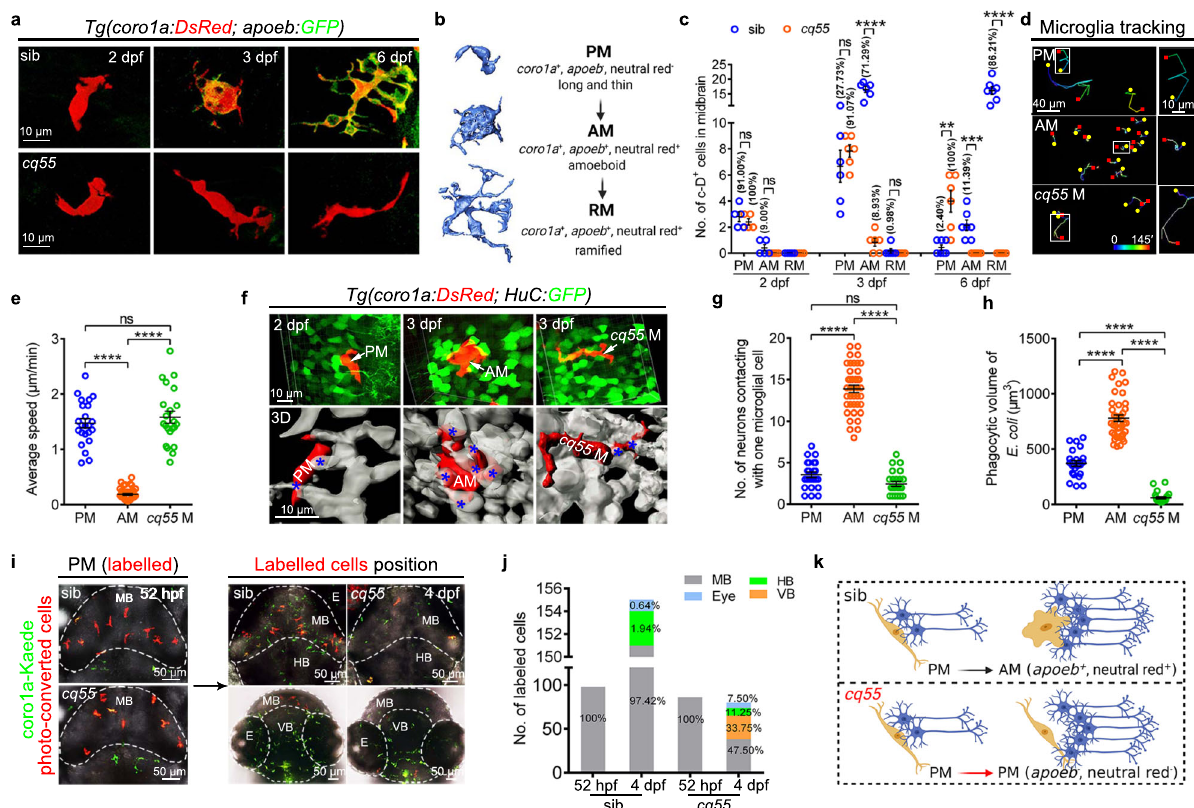
Fig.1|Microglialdifferentiationinalarvalzebra fi shmidbrain.a Representative images of midbrain microglial cells. b Zebra fi sh microglial development process. c The numberand proportion of PM, AMand RM in midbrains(2dpf: siband cq55 : n =5; 3 dpf: sib and cq55 : n =6; 6 dpf: sib: n =7, cq55 : n =6). Each dot denotes one fi sh. d The movement trajectory of c-D + cells during 145min. Each line represents one cell. The right panels are the enlarged images of boxed cells. The yellow circle andredsquareindicatesstartandendpoints,respectively. e Themovementspeed of c-D + cells in d ( n =23 PM, 41 AM and 22 cq55 M from 6 fi sh per group). f Representative images (top) and 3D reconstructions (bottom) of c-D + PM, AM or cq55 M (red) contacting HuC-GFP + neurons (green and white colors in top and bottom panels). White arrows and blue asterisks mark the c-D + cells and touched neurons. g The numbers of H-G + neurons contacting PM, AM or cq55 M ( n =24 PM